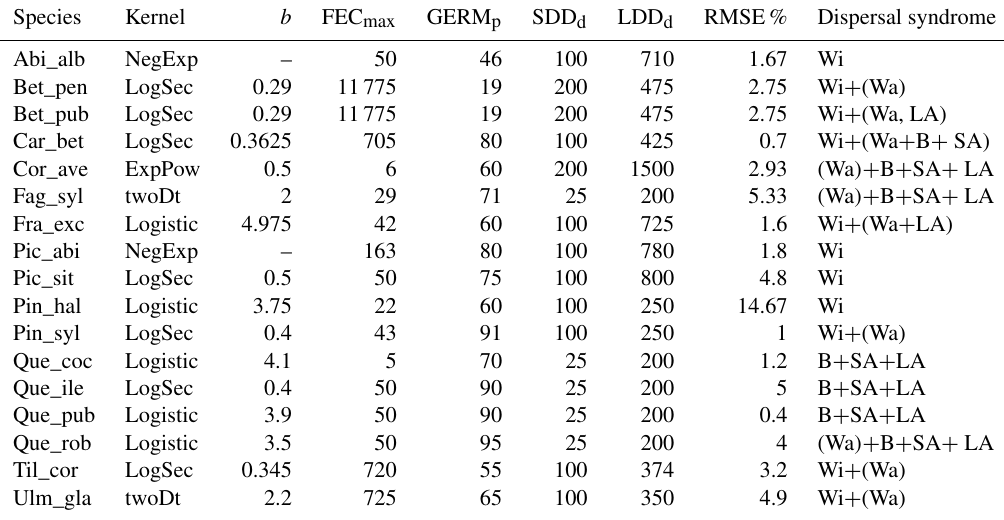
Table B3. Species-specific optimal migration parameters with related RMSE% (relative to the maximum value of historical estimates; see upper boundaries in Table 1) and dispersal syndromes as reported by the TRY Database (Kattge et al., 2020) and supporting literature (see Table B1): Wi: wind; Wa: water; B: bird; LA: large mammal (deer, badger, cattle); SA: small animal (e.g. hoarding by rodents). Secondary mechanisms of dispersal are in